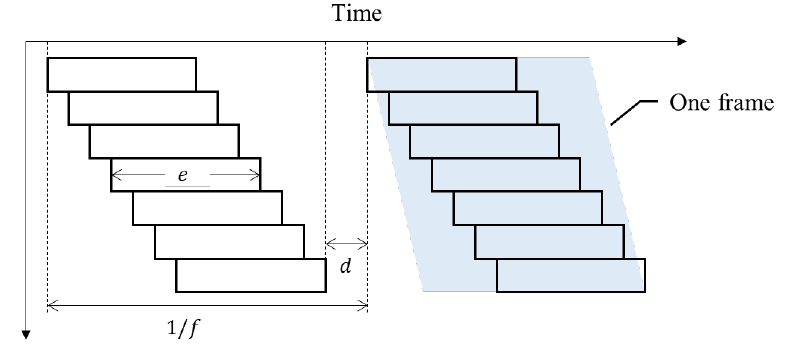
Figure 1. Rolling shutter camera exposure timeline.